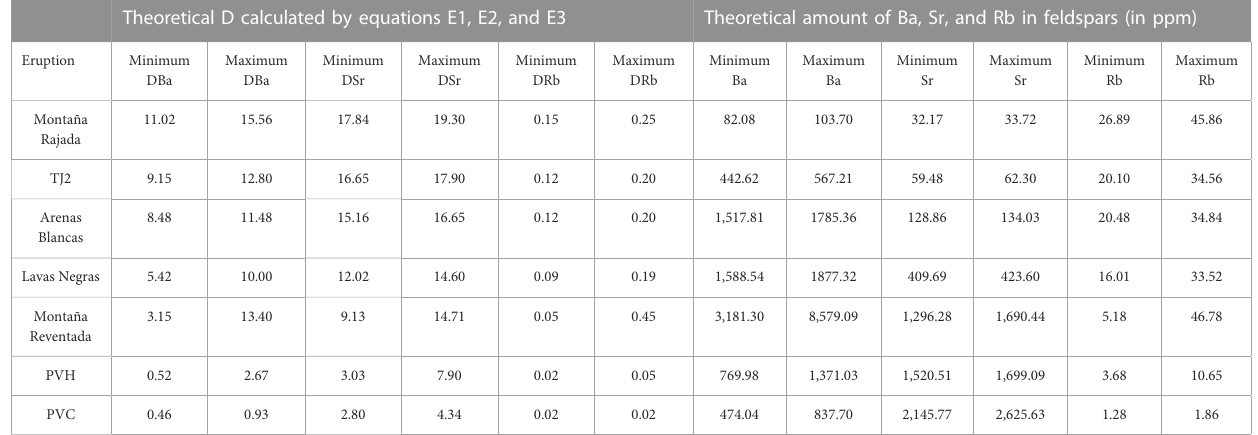
TABLE 2 Table showing a summary of the theoretical D i ranges calculated by equations E1, E2, and E3 for each Teide-Pico Viejo eruption studied in this work, as well as the predicted quantities of Ba, Sr, and Rb that feldspars in equilibrium with the whole rock composition should contain. Theoretical D calculated by equations E1, E2, and E3 Theoretical amount of Ba, Sr, and Rb in feldspars (in